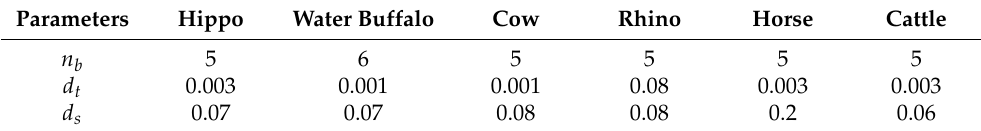
Table 2. Different values of parameters used in animal models. Parameters Hippo Water Buffalo Cow Rhino Horse